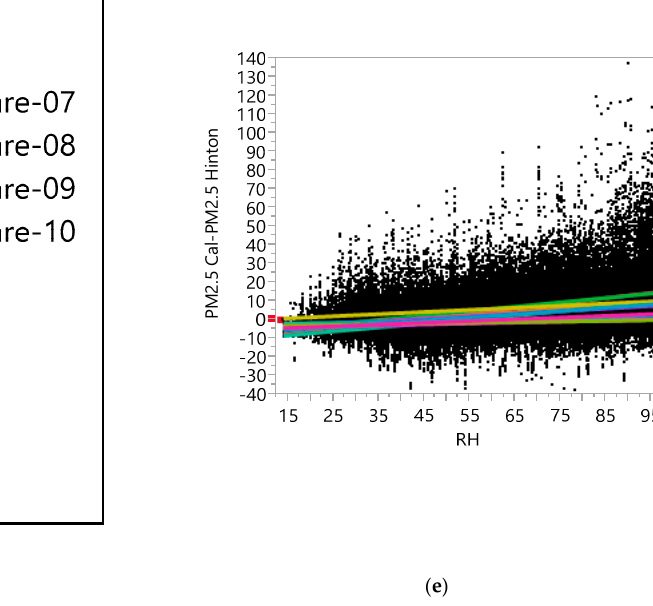
Figure 4. Regression Plot between PM 2.5 Raw-PM 2.5 Hinton Data versus the ( a ) Temperature ( b ) RH, ( c ) Wind Direction, ( d ) Wind Speed, ( e ) between PM 2.5 Calibrated-PM 2.5 Hinton Data versus the RH, as measured at the Hinton Reference Site.